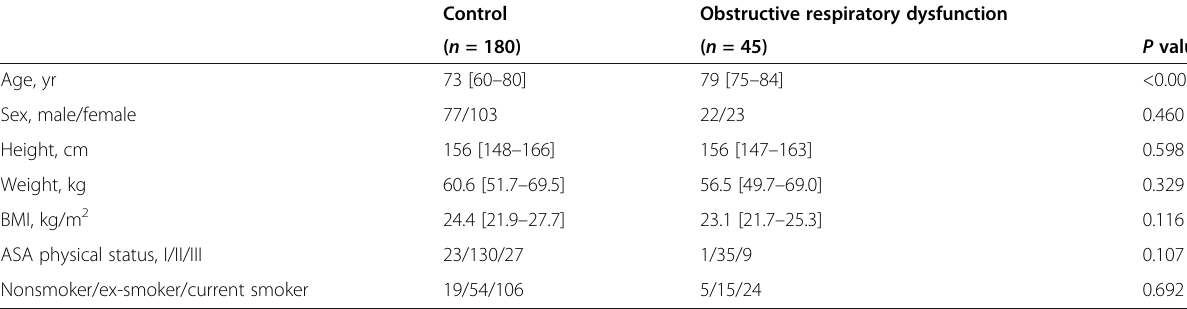
Table 2 Patients ’ characteristics